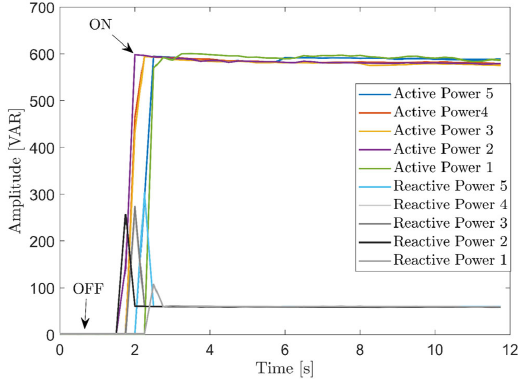
Figure 13. Example of acquired powers of an ON/OFF appliance.